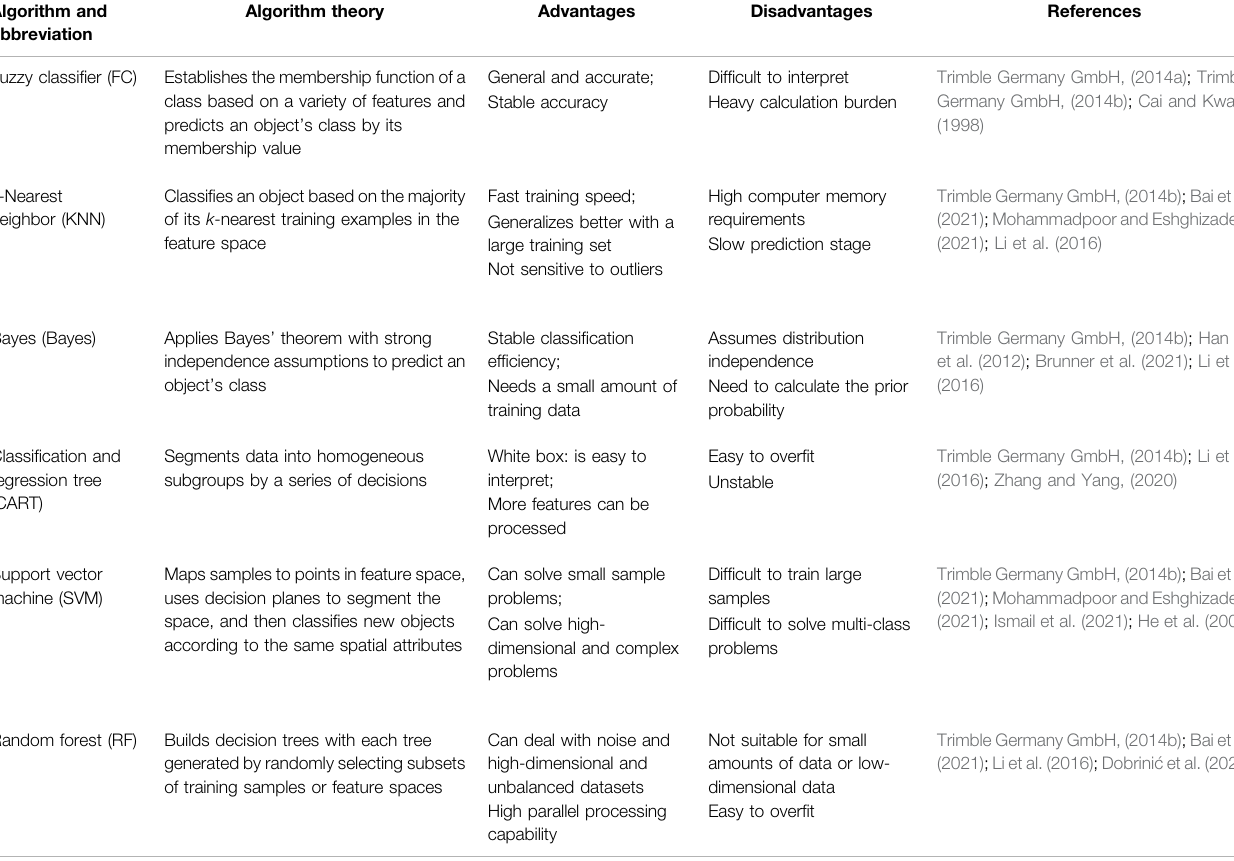
TABLE 1 | Six machine learning algorithms adopted in this study.